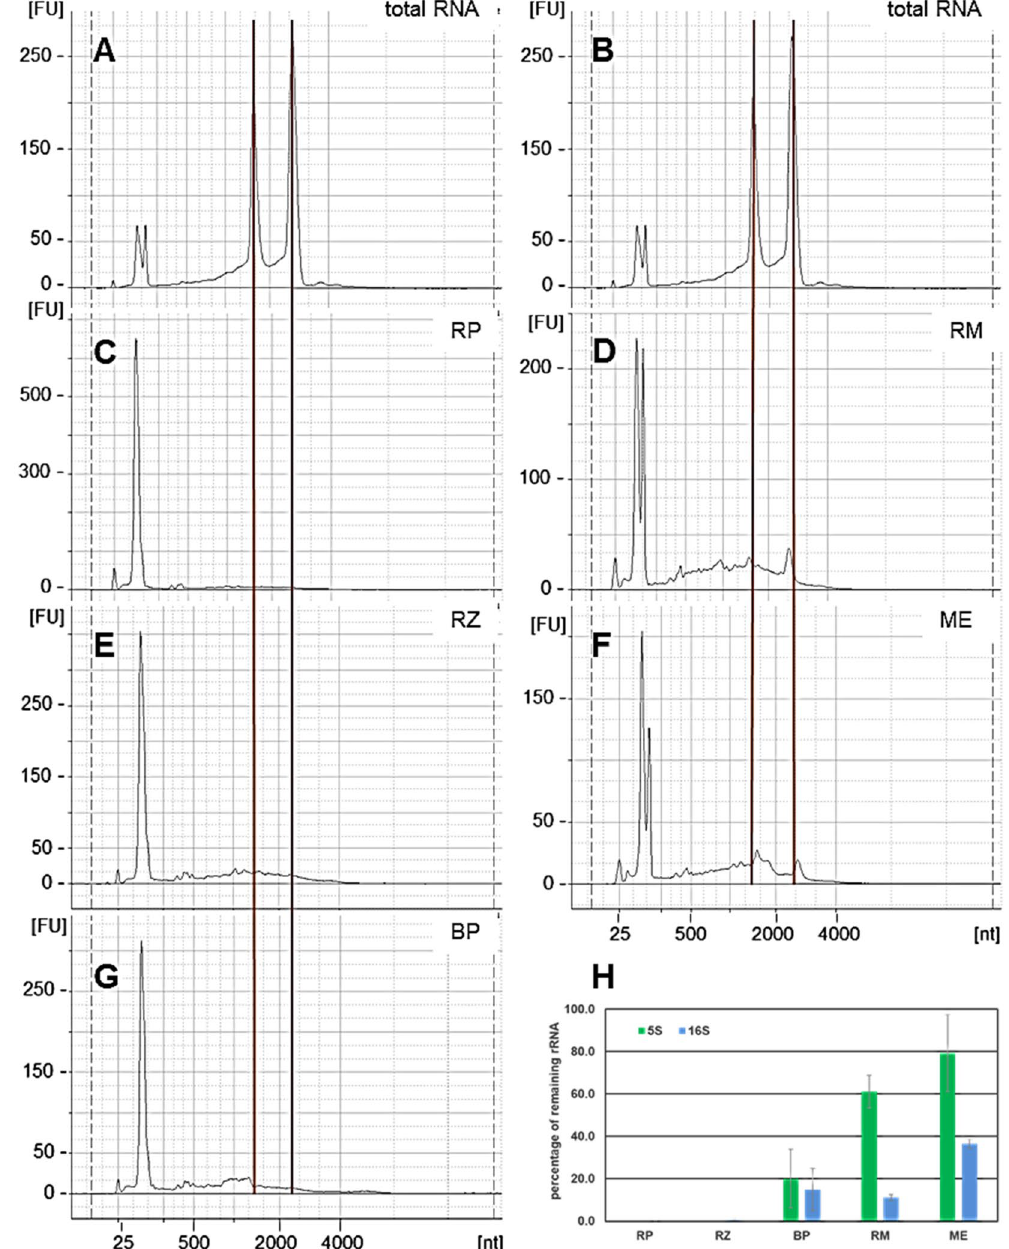
Figure 3. Electropherograms produced with the Bioanalyzer of RNA before and after depletion; the red lines indicate positions of 16S and 23S rRNA peaks, respectively. Total RNA untreated ( A ) RIN 8.9; ( B ) RIN 9.5. Both showing well-defined peaks of 16S and 23S rRNA signals. RNA depleted with ( C ) riboPOOL (RP); ( D ) RiboMinus (RM); ( E ) RiboZero (RZ); ( F ) MICROBExpress (ME); and ( G ) our biotinylated probes (BP). A strong decrease of the targeted rRNAs can be seen in the treated samples. Samples treated with RM and ME show some minor signals of remaining 16S and 23S rRNA. ( H ) Remaining amount of 5S and 16S rRNA after depletion, determined by qPCR. The amount of 100% was set for each quantified rRNA in the untreated total